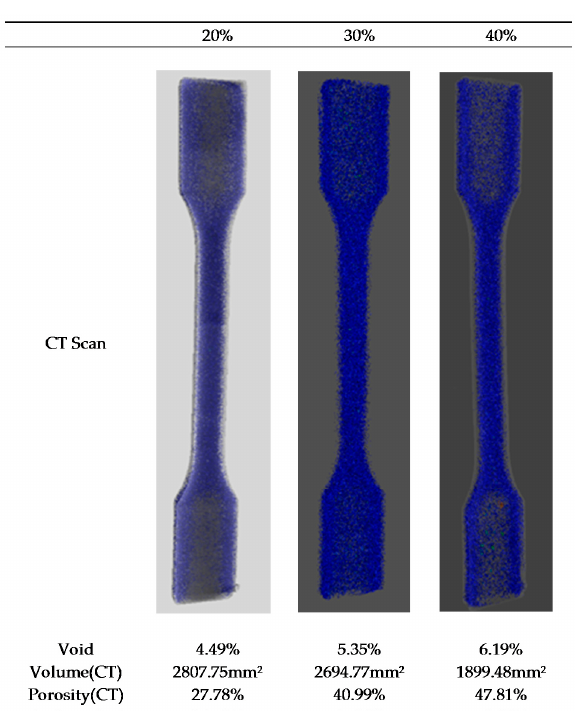
Figure 15. Comparison of sintered part with varied contents of polymethyl methacrylate (PMMA) shrinkage and porosity ( a ) shrinkage and ( b ) porosity effect of PMMA size.